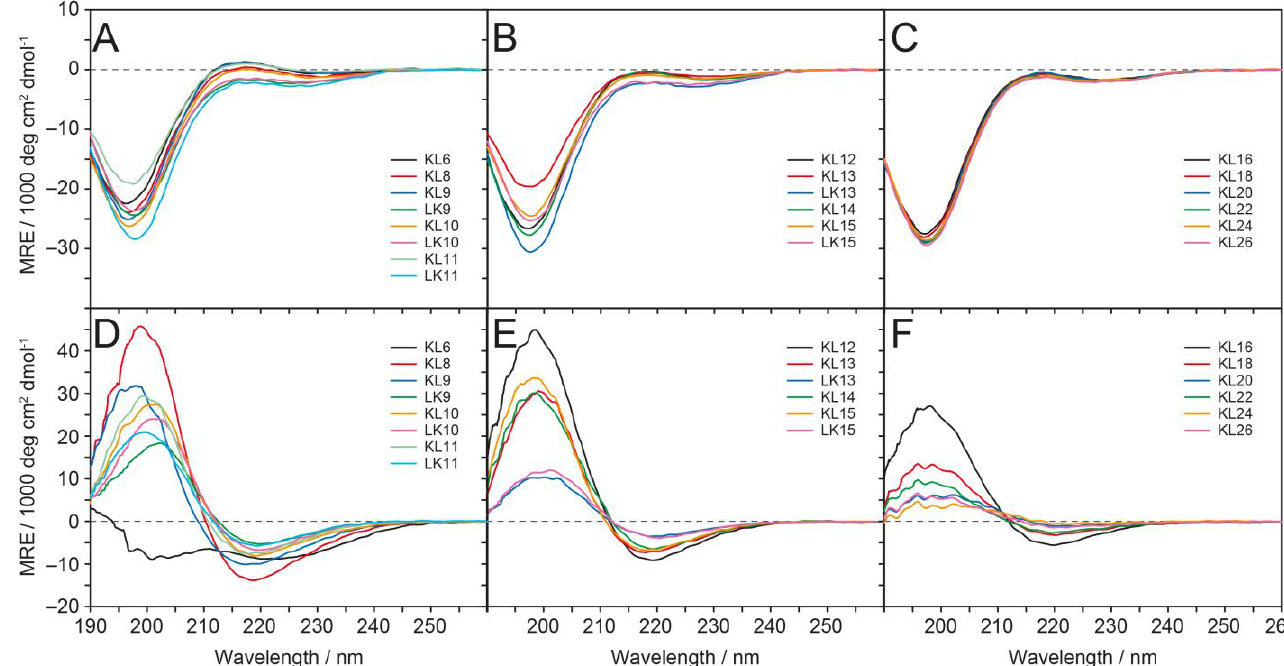
Figure 2. Circular dichroism spectra of KL and LK peptides (including KL6, KL10, KL14 and K18 from ref. [15]). ( A – C ) CD spectra in pure water at pH ≈ 5 – 6, with a peptide concentration of 0.1